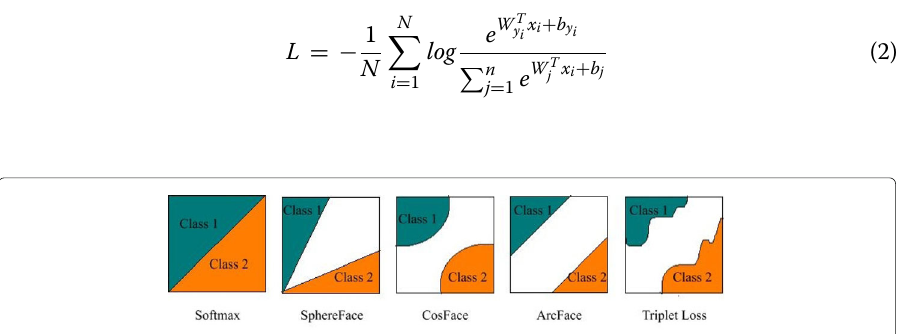
Fig. 4 Classification boundaries of different loss functions in binary